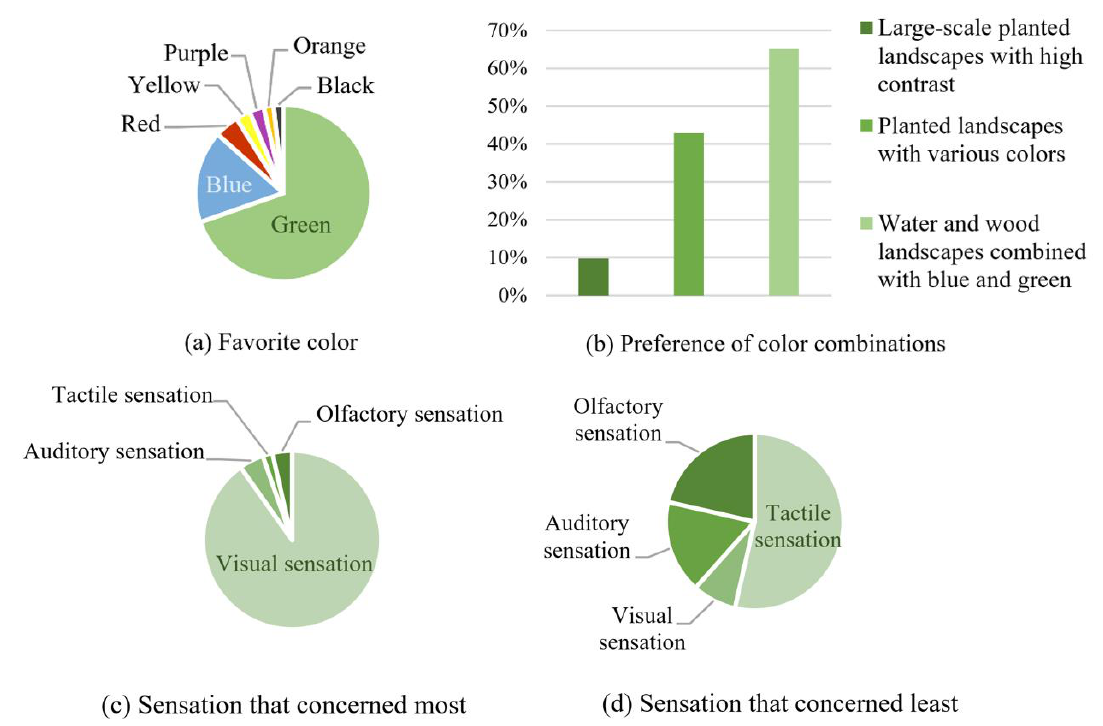
Figure 5. Description of surveyed children’s perceived preferences in the urban forest park. ( a ) Favorite color; ( b ) preference of color combination; ( c ) sensation that concerned them the most; and ( d ) sensation that concerned them the least. Items ( a , c , d ) were set as single-choice questions, while item ( b ) was set as a multiple-choice question.